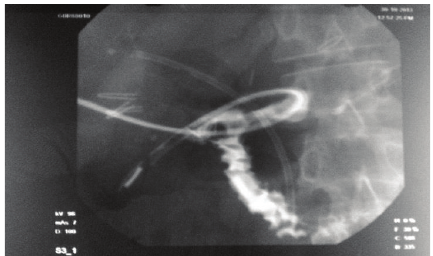
Figure 4: Tube conray gram showing the dye filling up in the duodenum without evidence of any intraperitoneal leak.